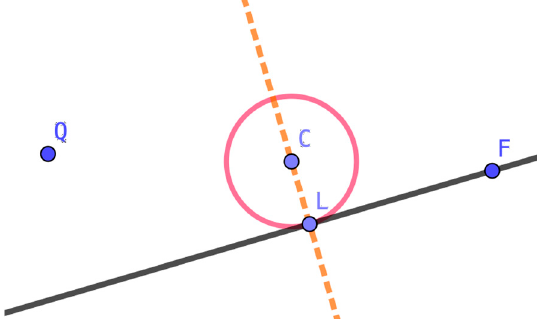
Figure 3. The center C of a tangent circle to a given line lies on the perpendicular to the line at the tangency point L.